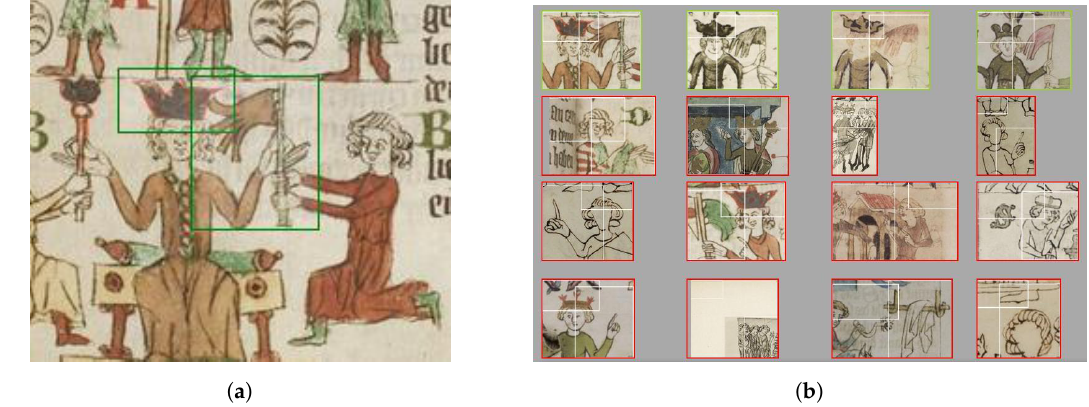
Figure 2. ( a ) Shows the user-selected queries on a sheet from the Sachsenspiegel (c1220); ( b ) presents the obtained search results using the interface. Image rights: Heidelberg University Library, https: